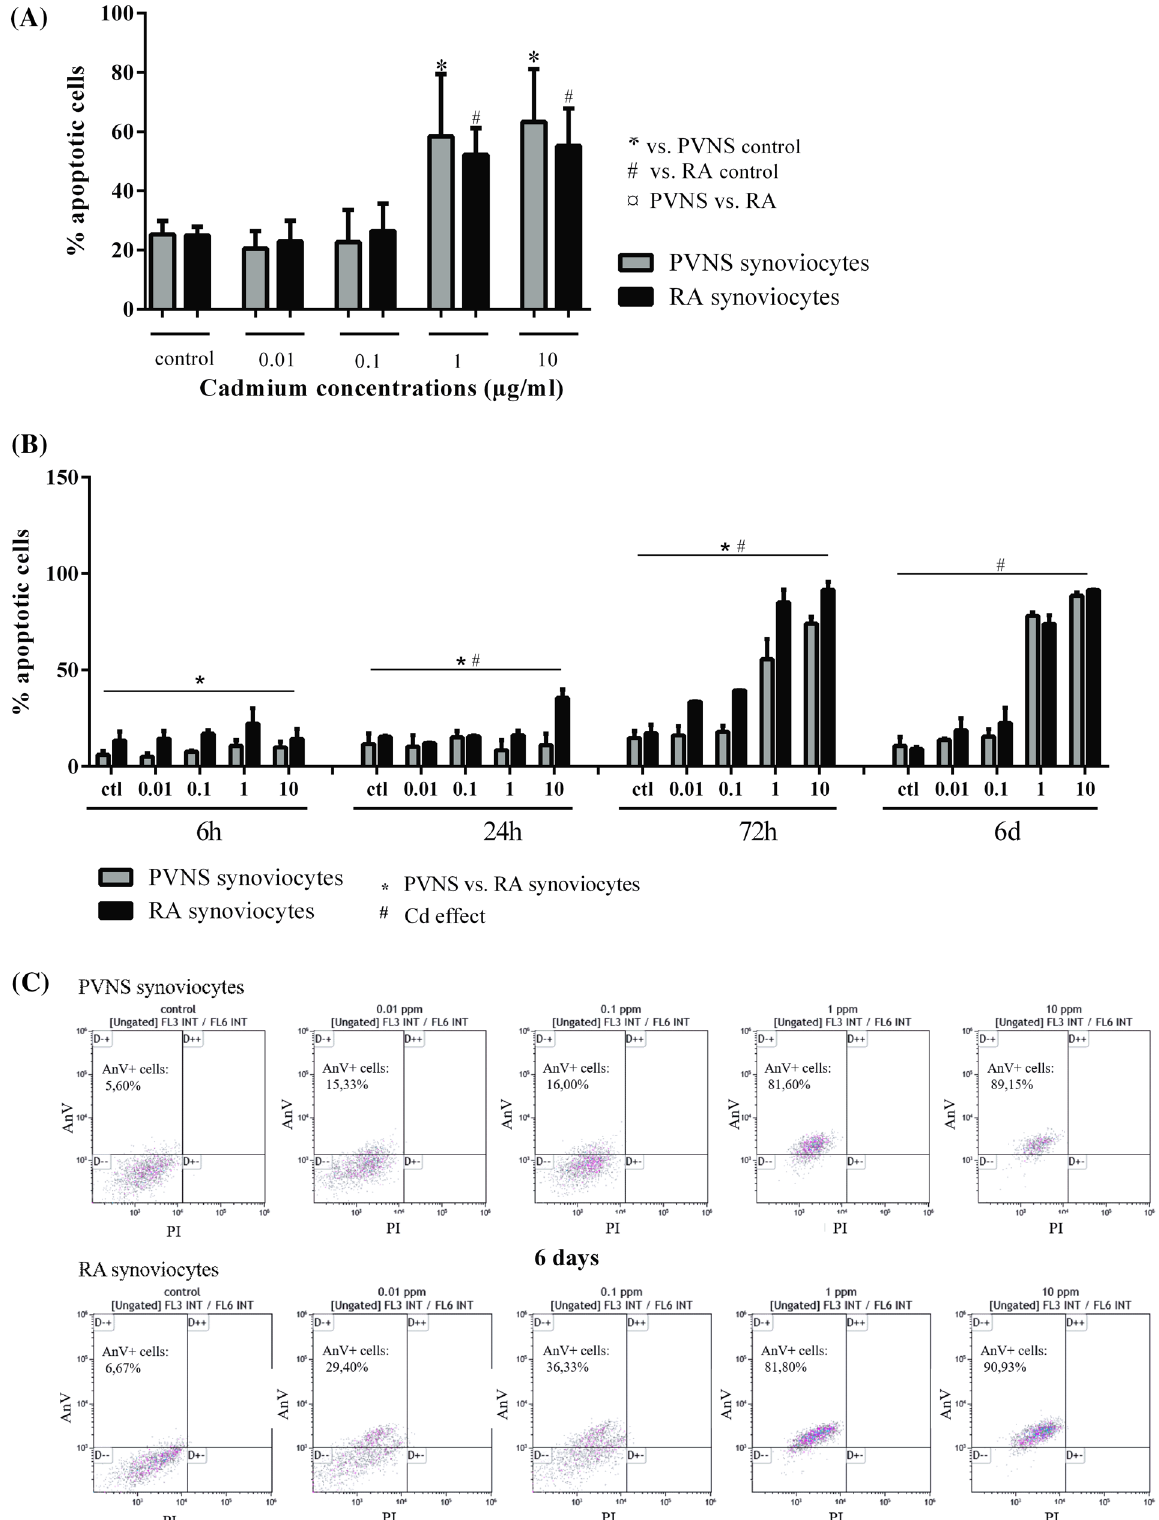
Figure 3. Quantification of apoptotic cells in cultures of PVNS and RA synoviocytes 6 days after Cd exposure. After 6 days ( A , n = 5 from 5 PVNS patients and 5 RA patients) of treatment with Cd (0.01 ppm; 0.1 ppm; 1 ppm and 10 ppm) or in independent experiments, following kinetics (6 h, 24 h, 72 h and 6 days; B , n = 3 from 3 PVNS patients and 3 RA patients), Annexin V staining of PVNS and RA synoviocytes, used between passages 4 to 9, was done to evaluate if cell death induced by Cd is mediated through apoptosis. Results are presented as mean ± SD, * p < 0.05. ( C ) The FACS plots obtained for cells from one PVNS and one RA patient, at day 6, for the different concentrations of